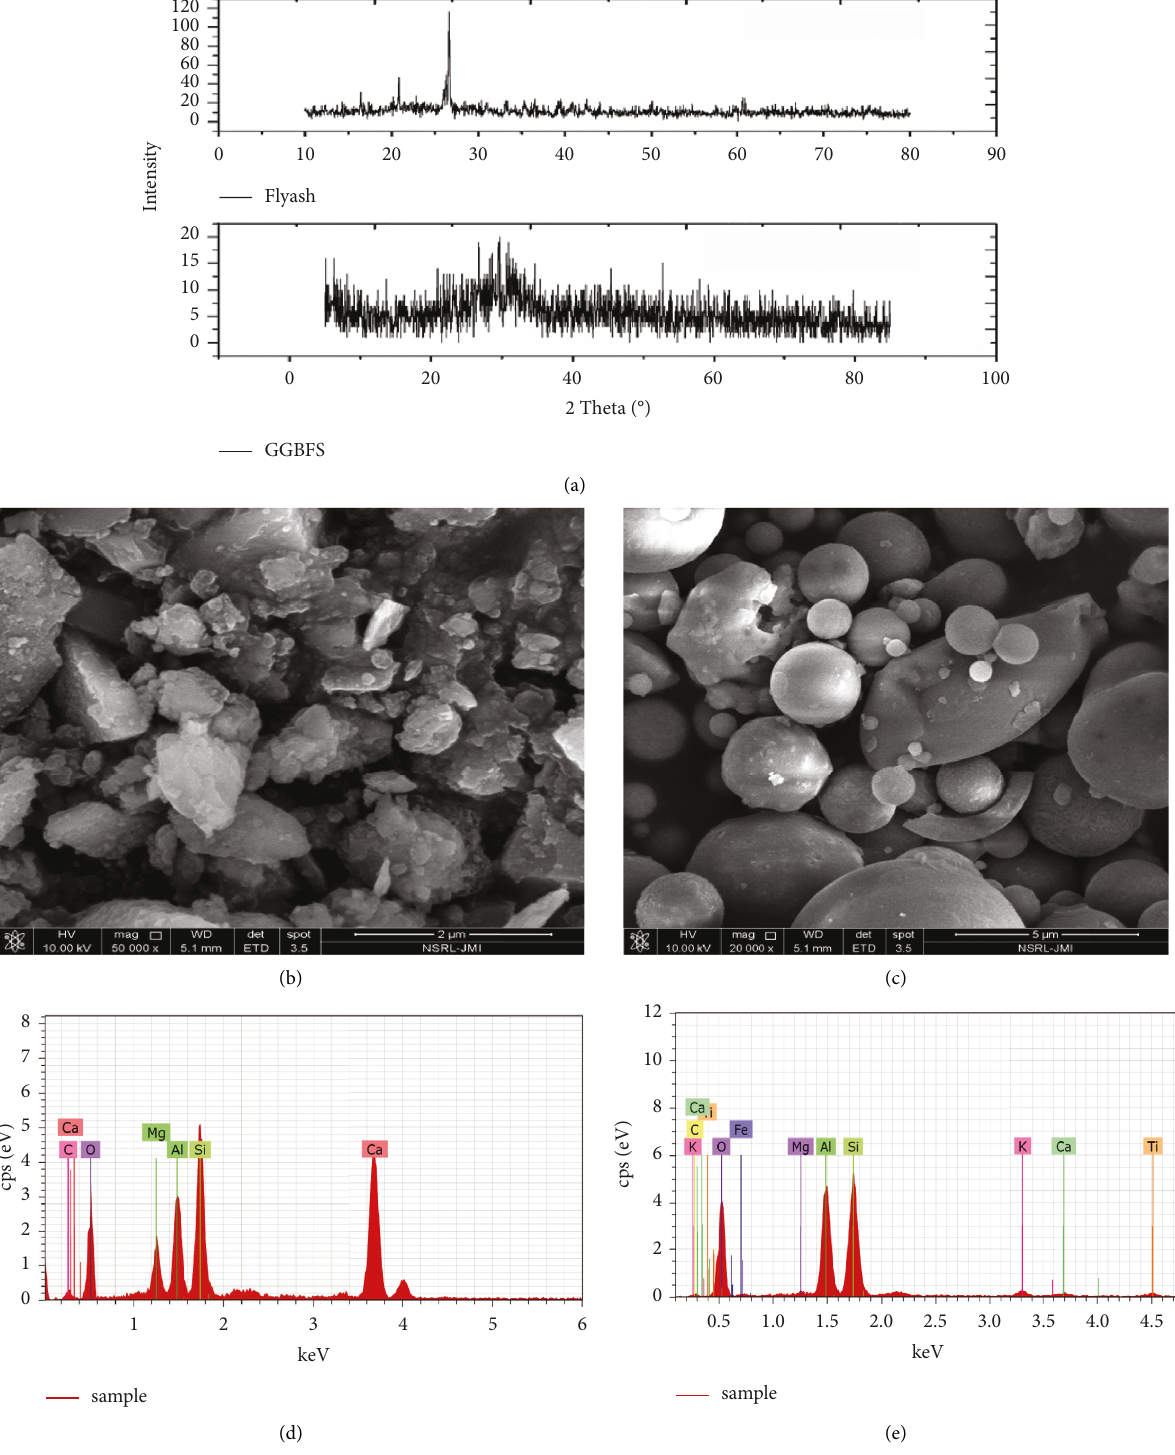
Figure 1: (a) XRD pattern of fly ash and GGBFS; (b) SEM image of GGBFS; (c) SEM image of fly ash; (d) EDS graph of fly ash; and (e) EDS graph of